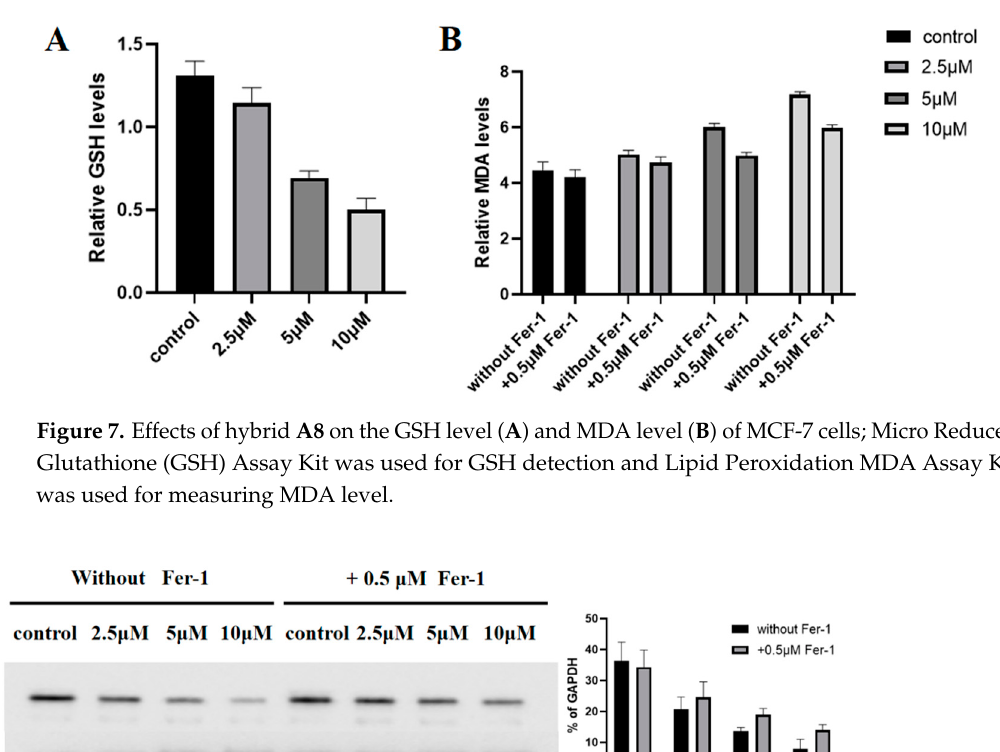
Figure 7. Effects of hybrid A8 on the GSH level ( A ) and MDA level ( B ) of MCF-7 cells; Micro Re- duced Glutathione (GSH) Assay Kit was used for GSH detection and Lipid Peroxidation MDA As- say Kit was used for measuring MDA level.